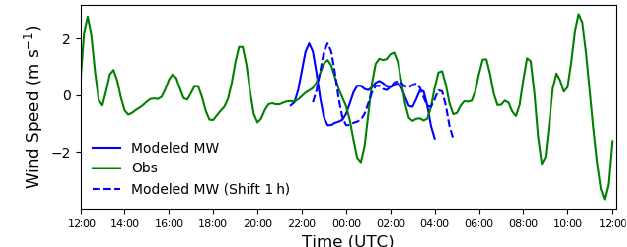
Figure 11. Observed (green) and reconstructed (blue) simu- lated 100m wind speed time series from 23 September 2016, at 12:00UTC, until 24 September 2016, at 12:00UTC. The simulated wind speeds were reconstructed with wavelengths from 8 to 18km, and periods were from 1 to 4h, while the observed winds were re- constructed with periods from 1 to 4h. The simulated mountain waves were plotted from 22:00 to 04:00UTC because the moun- tain wave event that we are interested in is particularly visible at that time. The dashed time series indicates the simulated mountain waves that were shifted by